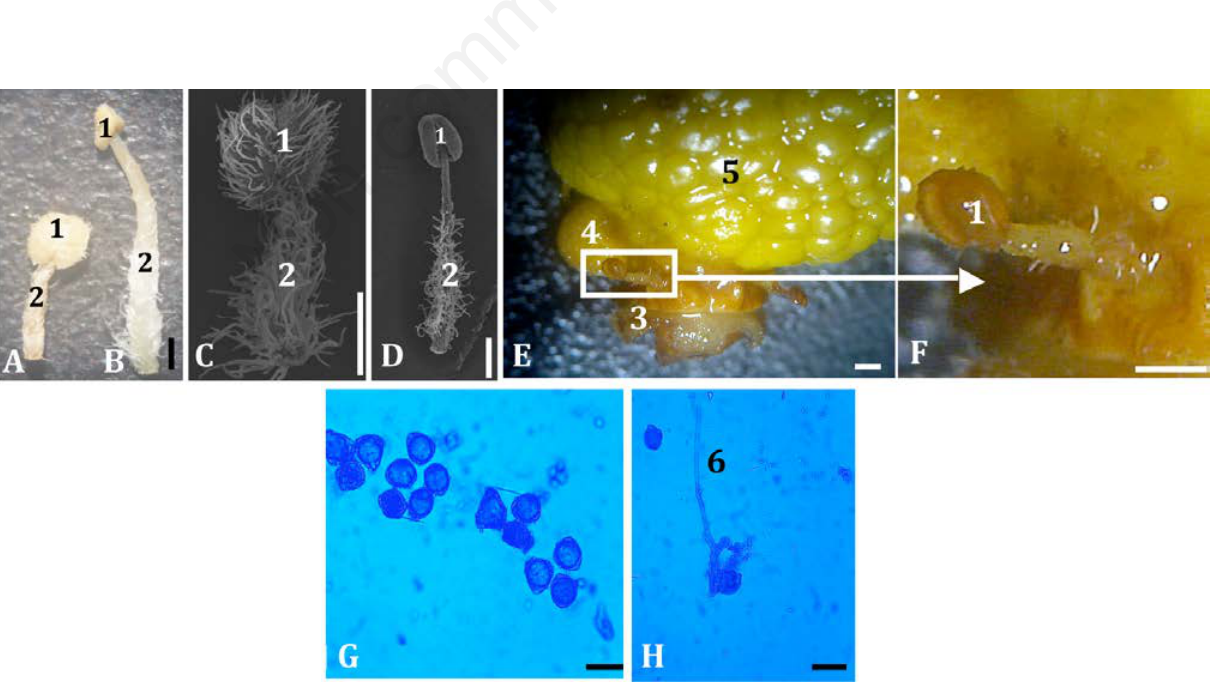
Figure 3. Stamen and pollen of pulasan: A,C) hermaphrodite stamen; B,D) staminate stamen; E,F) stamen on four-week-old fruit; G,H) viable and germinated pollen on hermaphrodite flower. Scale bar A-D=0.5 mm, E,F=1 mm, G,H=20 µm. 1: Anther; 2: filament; 3: sta- men; 4: reduced ovary; 5: developed ovary, young fruit 6: pollen